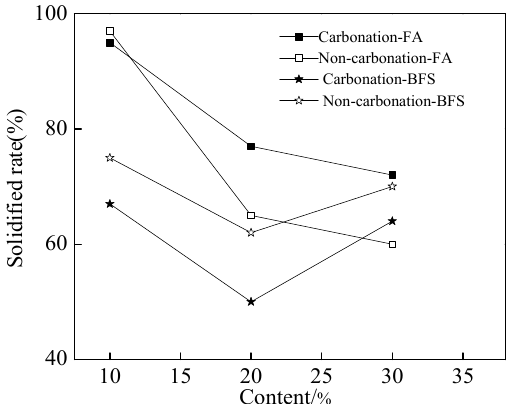
Figure 3. The solidified rate of chloride ions of cement paste.